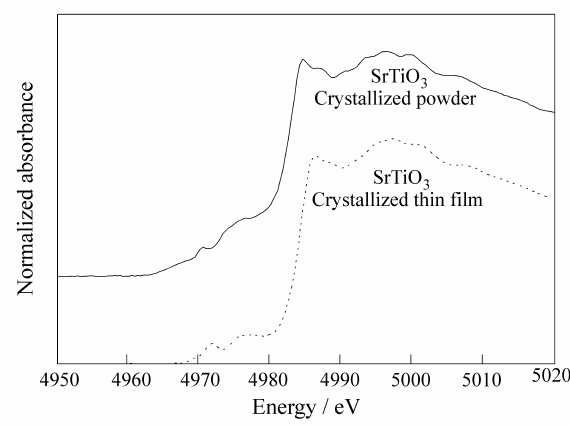
Figure 2. Ti K-edge XANES spectra of SrTiO 3 crystallized thin film compared to the SrTiO 3 crystallized powder sample.